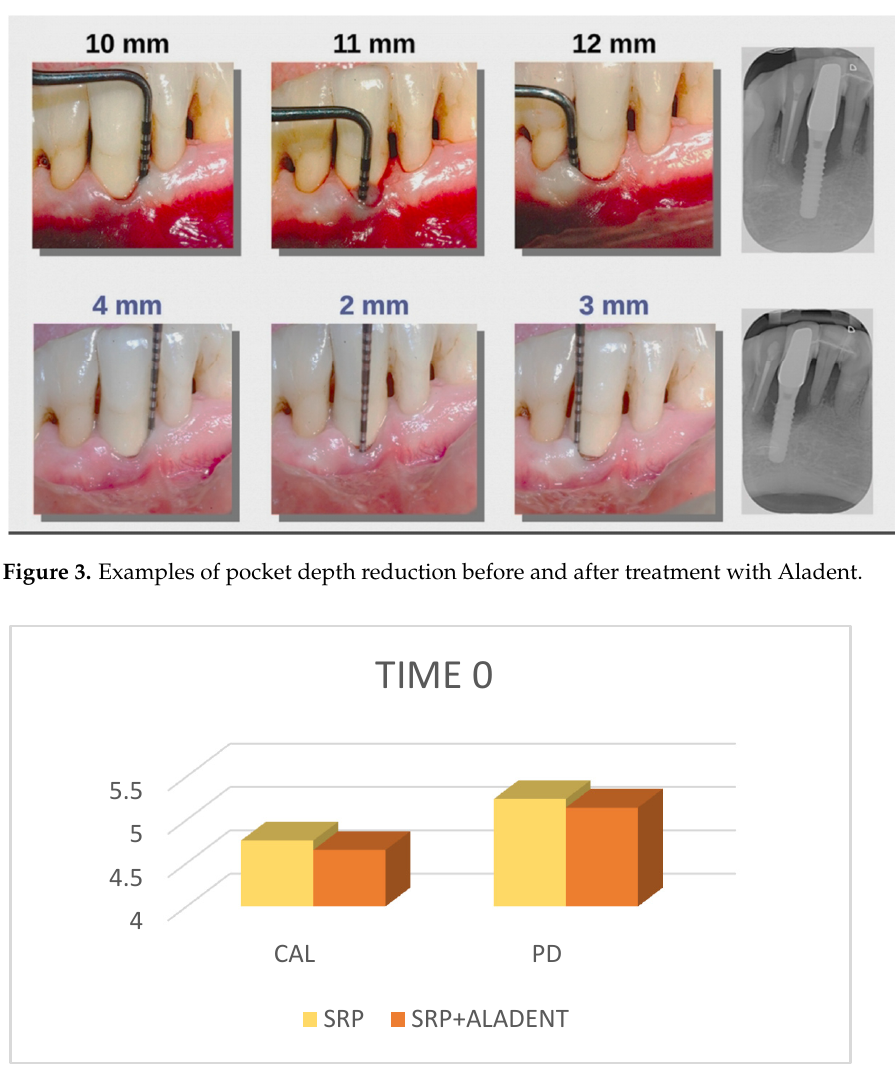
Figure 4. CAL and PD mean values (mm) of the selected sites before treatment with SRP alone and SRP plus ALADENT.